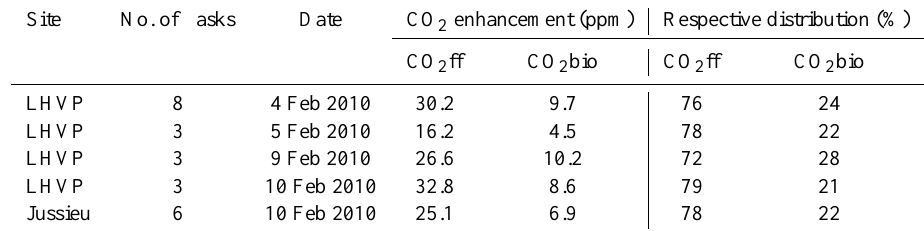
Table 3. CO 2 ff and CO 2 bio emissions with their respective contributions derived at the LHVP and at Jussieu.